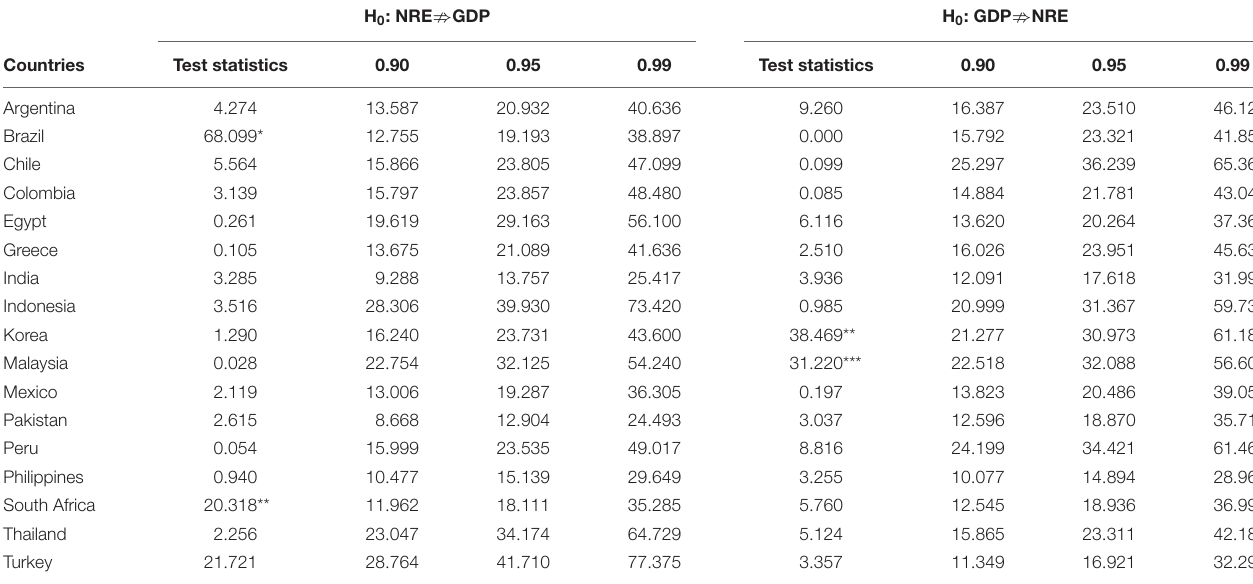
TABLE 4 | bootstrap panel causality test results for